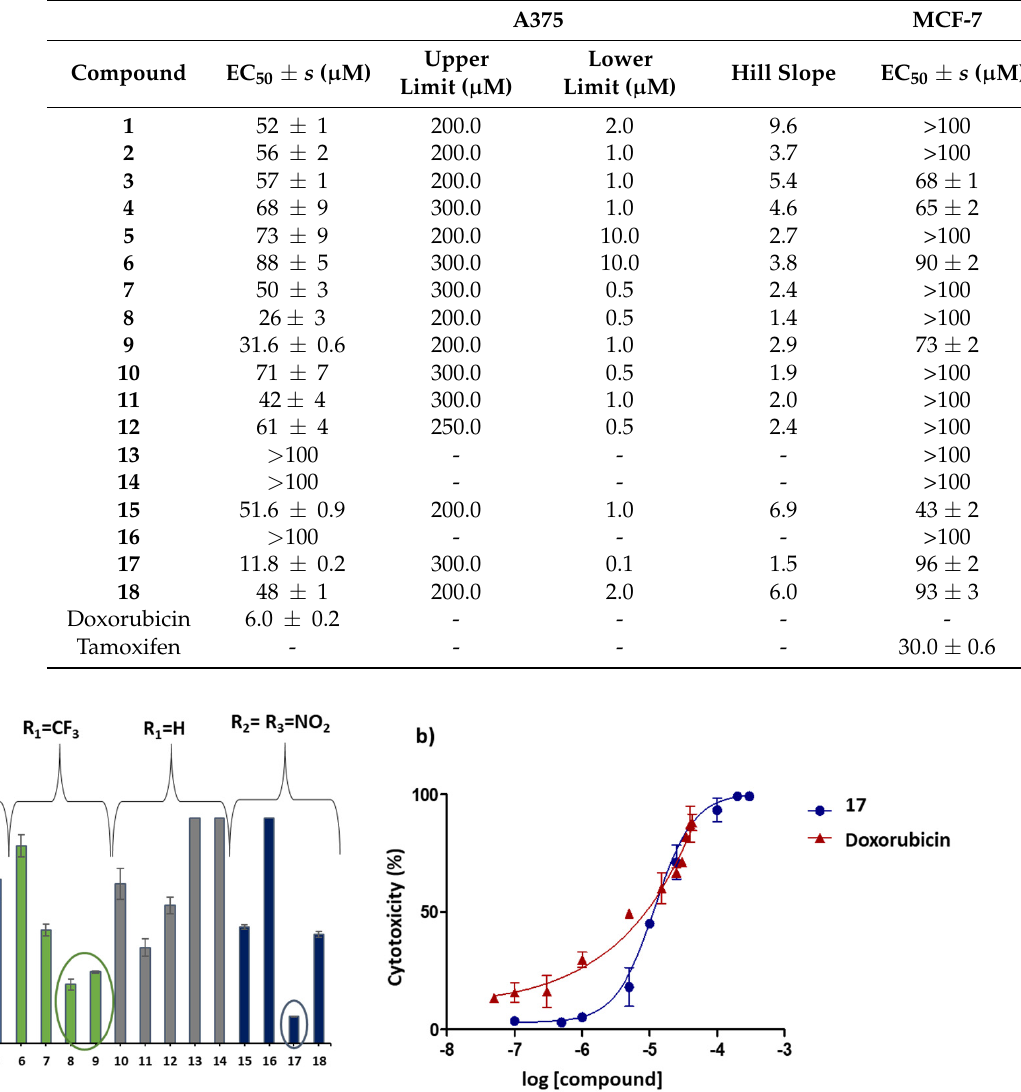
Table 3. EC 50 values ( µ M) and respective standard deviations ( s ) obtained for compounds 1 − 18 for MCF-7 and A375 cell lines, after incubation at 37 ◦ C for 24 h.